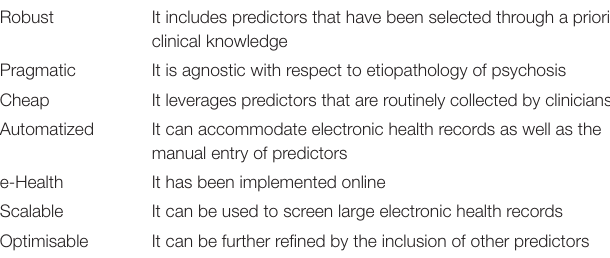
TABLE 1 | Core characteristics of the transdiagnostic risk